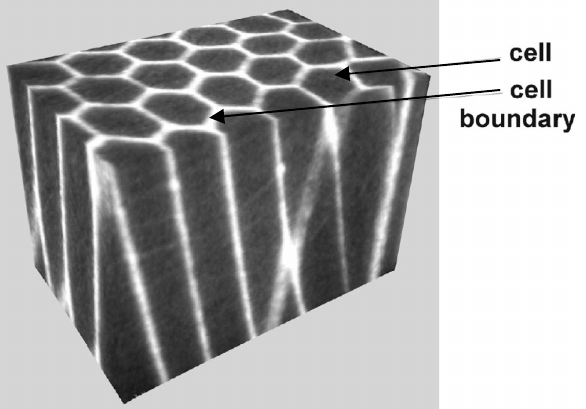
Figure 1. Scheme of a functionally designed cellular microstructure (reprinted with permission from